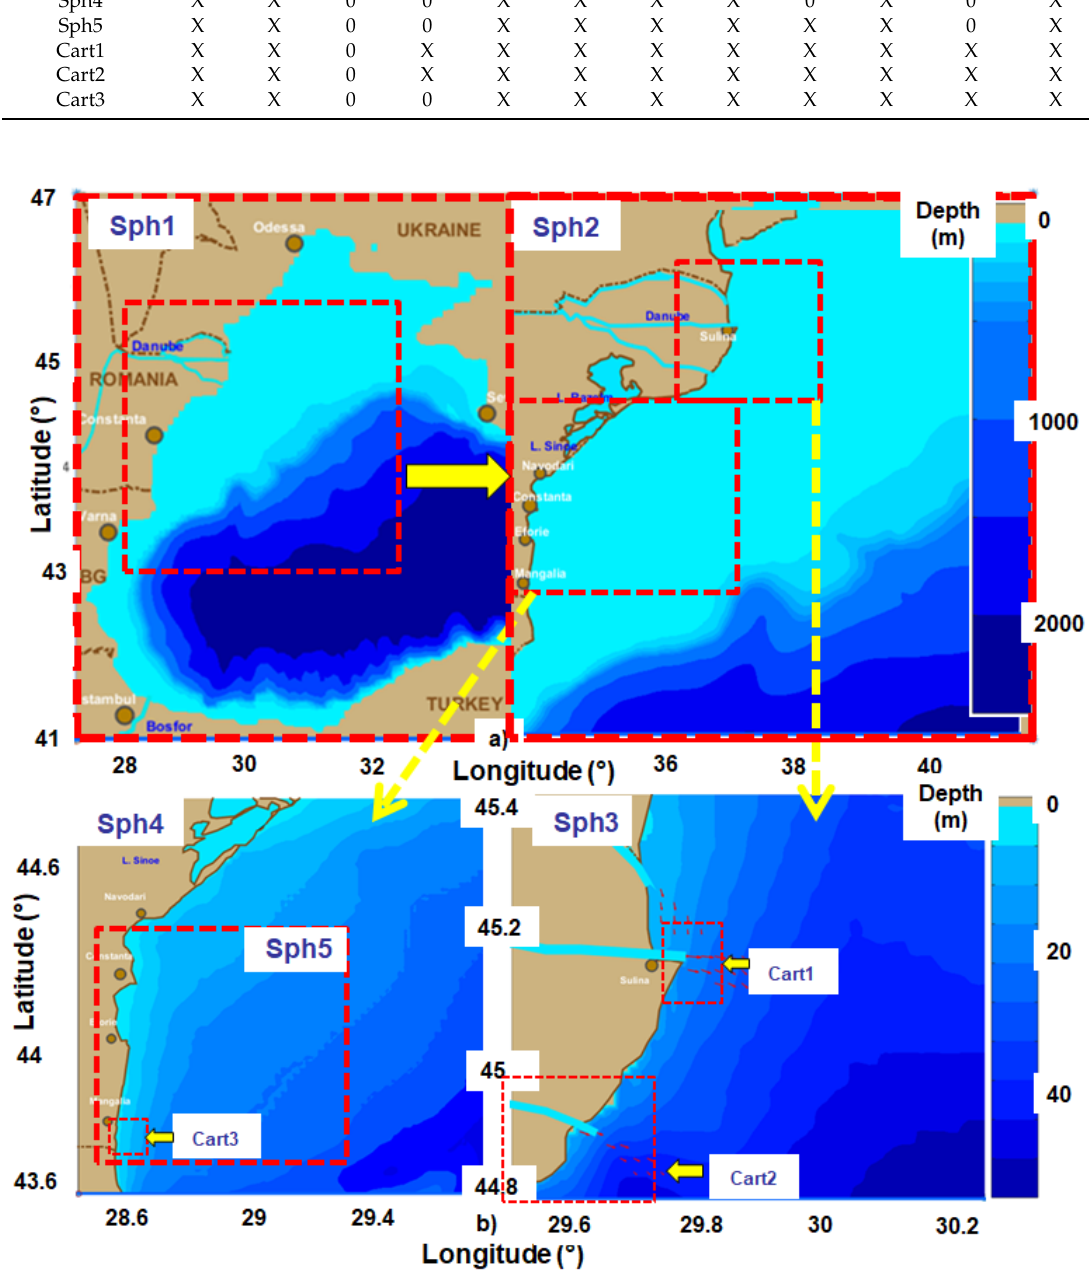
Figure 1. The computational domains defined in spherical coordinates: ( a ) Sph1—Black Sea basin and Sph2 (right side)—western coastal driver; ( b ) Sph3—nearshore area at the mouths of the Danube River (right side); Sph4 and Sph5 (left side)—Southern RO1 and RO2. The positions of the three Cartesian domains are also indicated.